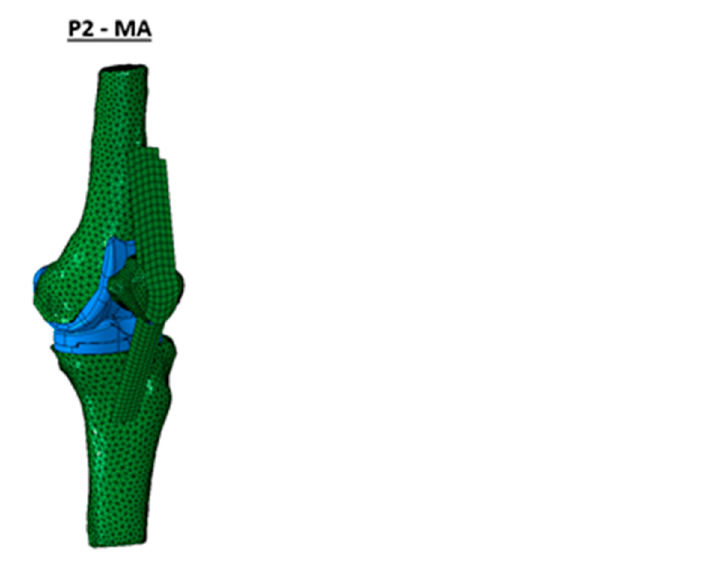
Figure 2. Illustration of the KA and MA configuration, in the finite element analysis, for the second used data set. Table 1. Hip-Knee-Ankle (HKA) angle configurations of the analyzed knee joints.